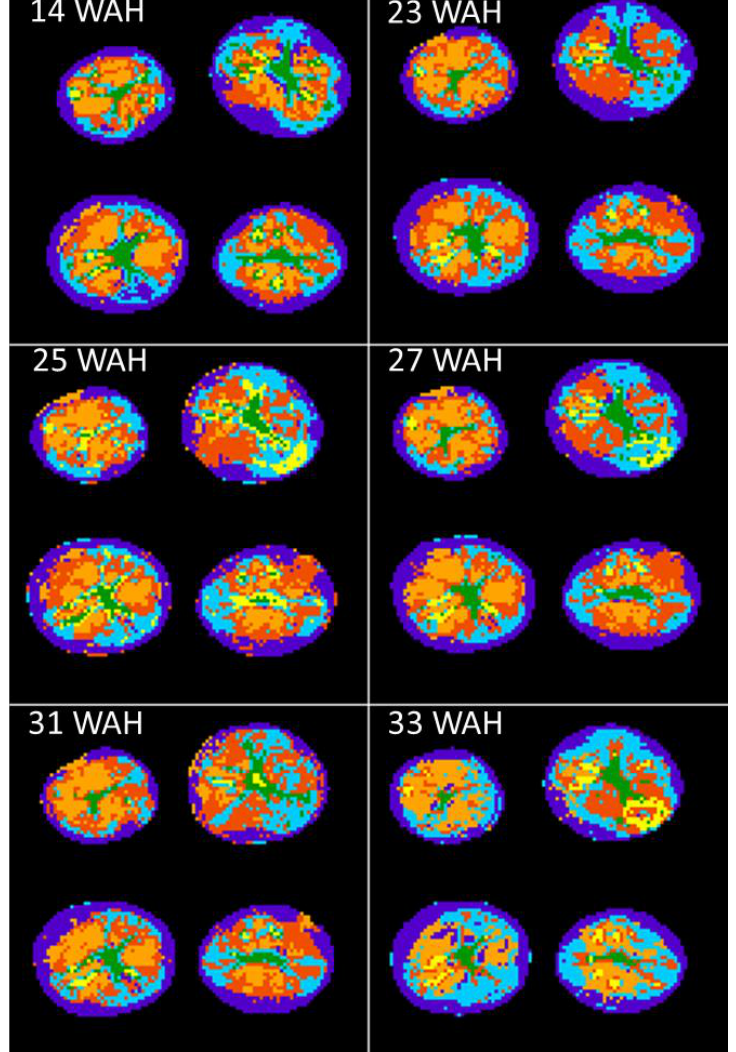
Figure 3. Classification for 14, 23, 25, 27, 31 and 33 WAH. Colors were attributed regarding both 𝑇 22 and spatial information as detailed in the text. On average, purple could be attributed to cortex, green to the pith and yellow to the defects, the three other colors, light and dark orange and cyan to the flesh Figure 4 shows the number of voxels for each class by sampling date. Each value corresponds to the sum of the number of voxels for all four tubers. The number of voxels in each class was relatively constant, demonstrating the robustness of the method. Excep- tions were observed for 33 WAH, where fewer voxels in the dark orange class were pre- sent, and 25 WAH, where more voxels fell into the yellow class. Indeed, for this sampling date, some of the voxels located in the cortex area were classified as defects, as can been seen in Figure 3.